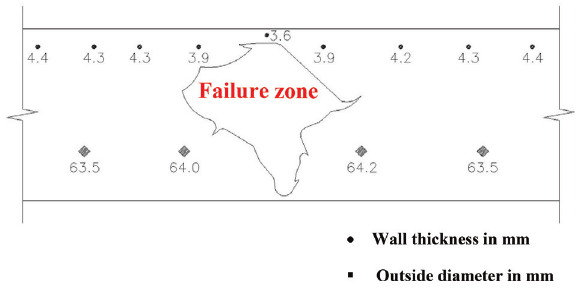
Figure 3: Wall thickness and outside diameter measurement of the failed